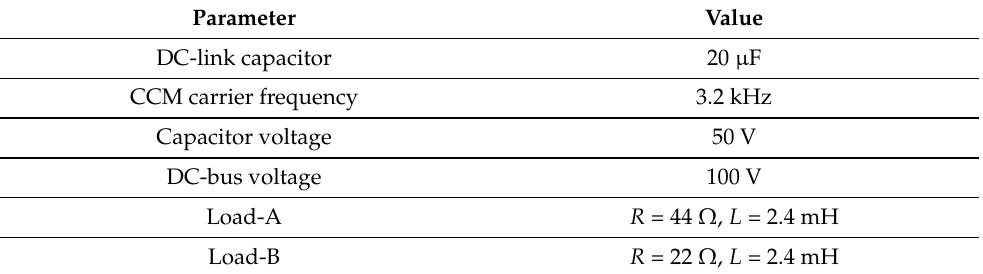
Figure 8. Experimental setup. Table 3. System Parameters of Seven-Level Inverter.